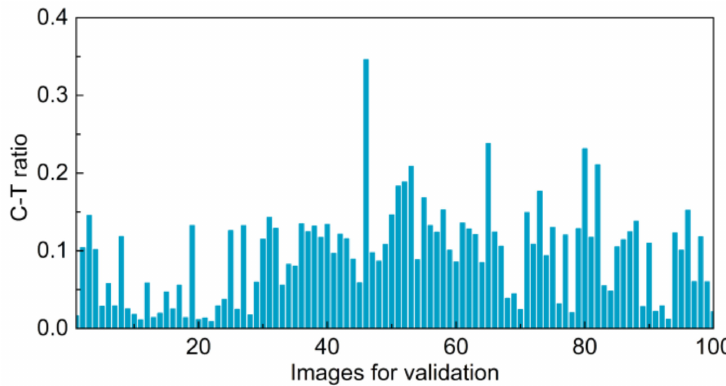
Figure 5. C-T ratios of images in validation